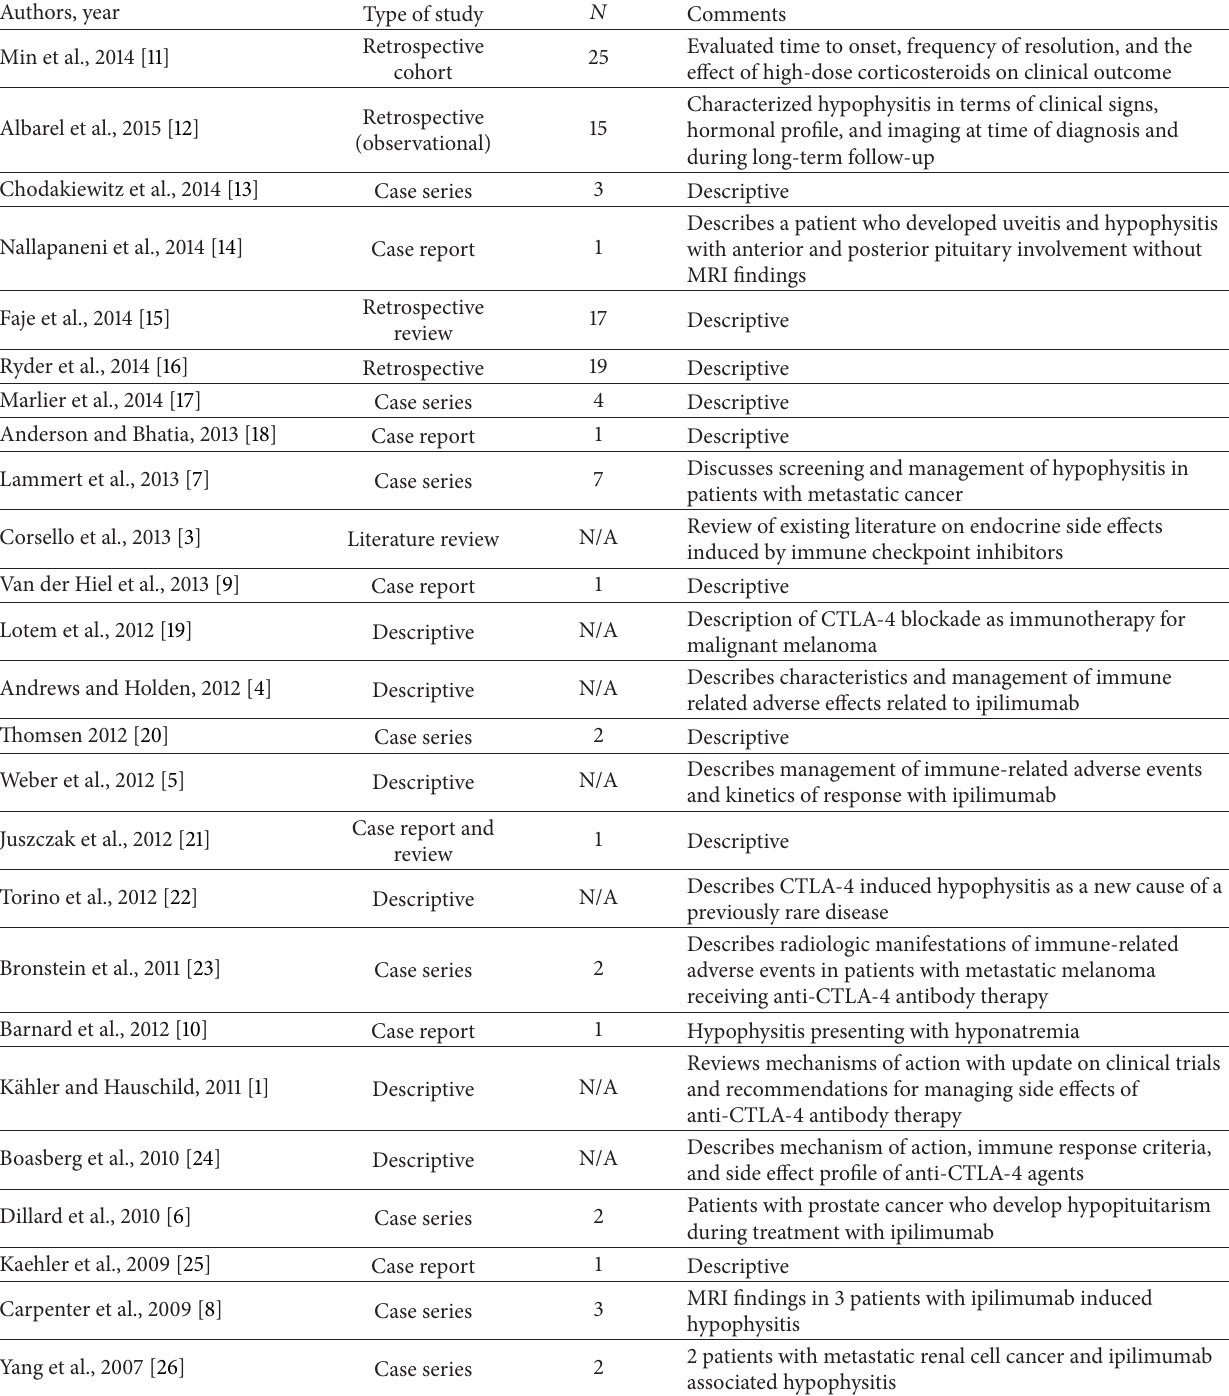
Table 4: Cases of anti-CTLA4 induced hypophysitis reported in the